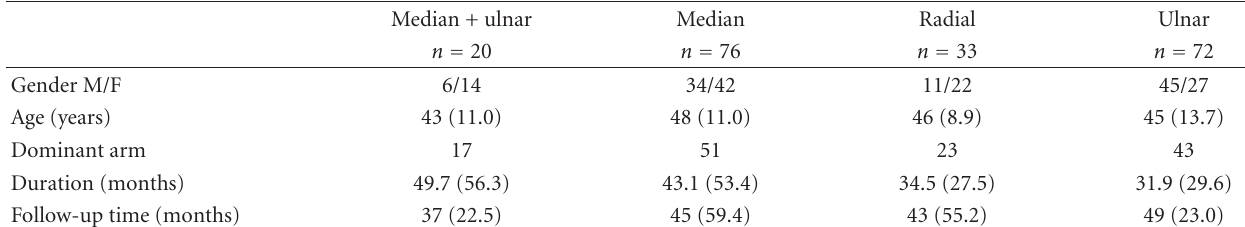
Table 1: Demographics. Study group. Figures represent mean, SD, and absolute numbers.